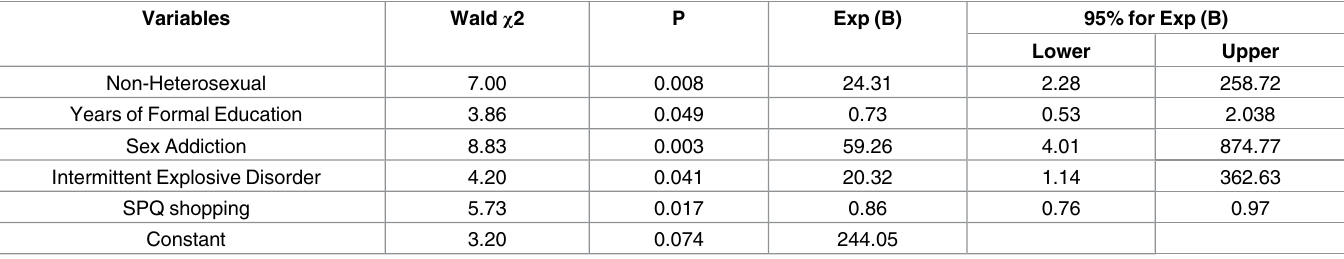
Table 4. Backwardbinary logistic regression with gender coded (0 = female, 1 = male), with variables associated p < .10 entered as predictors.